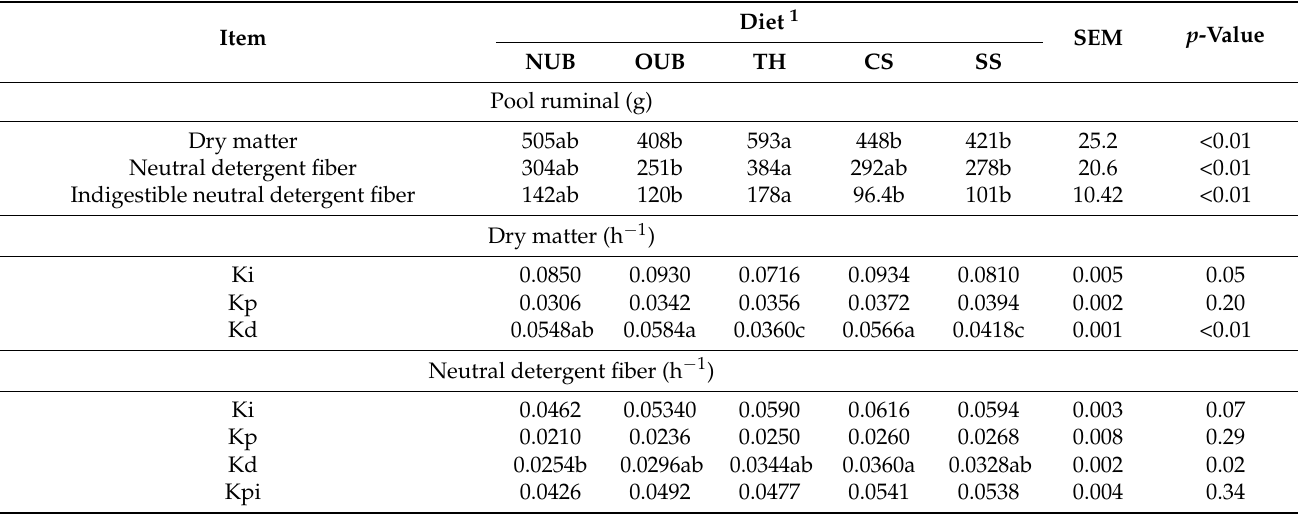
Table 5. Pool sizes and rates of ingestion (Ki), passage (Kp), and digestion (Kd) of DM e NDF, and passage rate of iNDF (Kpi).